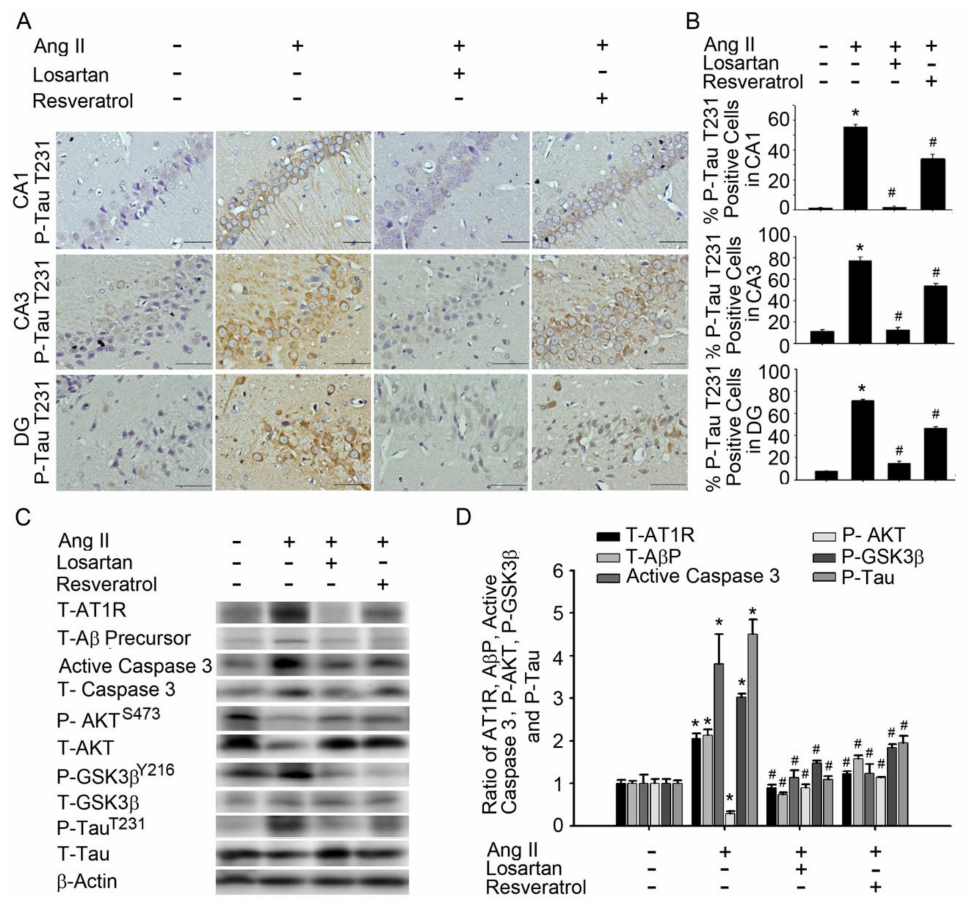
Figure 3. Resveratrol attenuated Ang-II-induced A β precursor and caspase 3-Akt-GSK-3 β Tau pathways in the hippocampus of AD rats. (A) In situ qualitative analysis of P-Tau T231 -immunopositive cells in the hippocampus of AD model rats. Scale bar, 200 mm. ( B ) Bar graph showing P-Tau T231 -expressing cells after treatment with Ang-II and/or losartan or resveratrol. Note the significant decrease in Ang-II-induced P-Tau T231 production after the administration of losartan or resveratrol. The percentage of P-Tau T231 -positive cells was determined by counting the P-Tau T231 -expressing cells in each hemisphere of the hippocampus (CA1, CA3, and DG) at × 200 magnification. These values were divided by the total number of cells in the same paraffin section. ( C ) Immunoblot demonstrating decreased levels of the proteins T-AT1R, T-A β precursor, T-active-caspase 3, P-GSK-3 β Y216 , and P-Tau T231 in the hippocampus after treatment with Ang-II and/or losartan or resveratrol. ( D ) Quantitative immunoblot analysis demonstrating reductions in T-AT1R, T-A β precursor, T-active-caspase 3, P-GSK-3 β Y216 , and P-Tau T231 expression in the hippocampus of rats with Ang-II-induced AD following treatment with losartan or resveratrol. The values are presented as the mean ± SEM; n = 6. * p < 0.05 vs. the WKY group. # p < 0.05 vs. the Ang-II